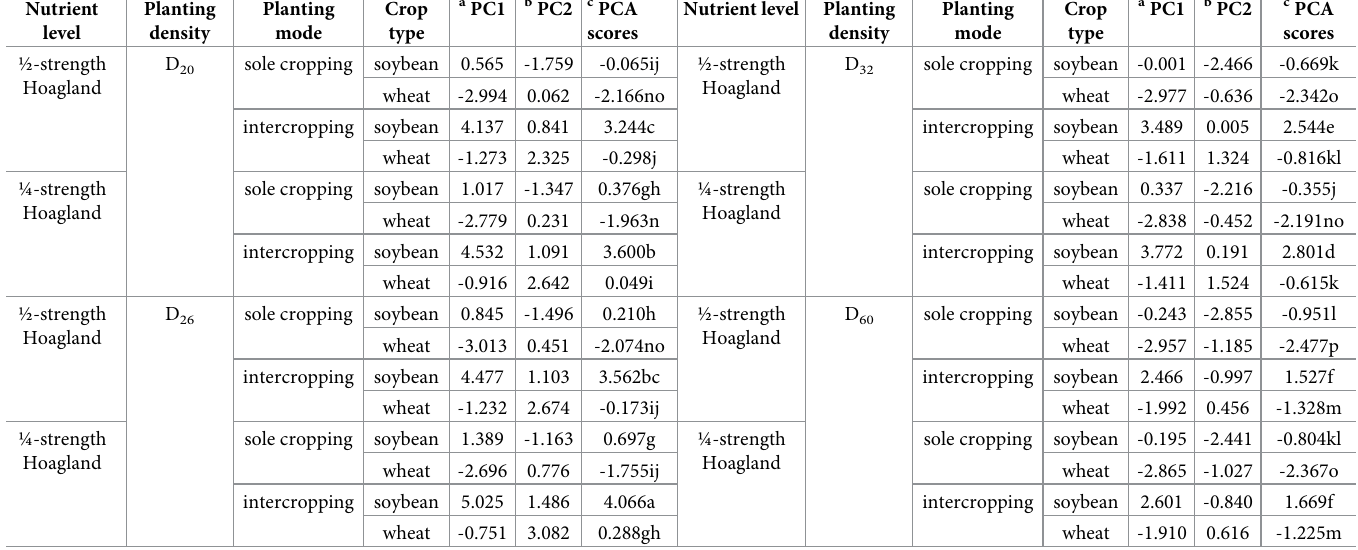
Table 4. The PCA of the growth status of soybean/wheat population in their sole cropping and intercropping populations at different nutrient levels and planting densities. Nutrient Planting level